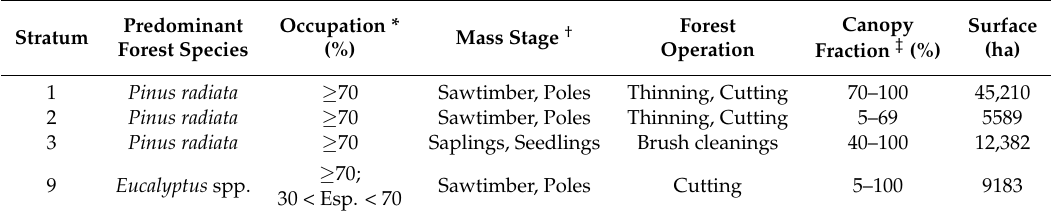
Table 1. Basic features of the strata from the Fourth National Forestry Inventory of the Province of Biscay